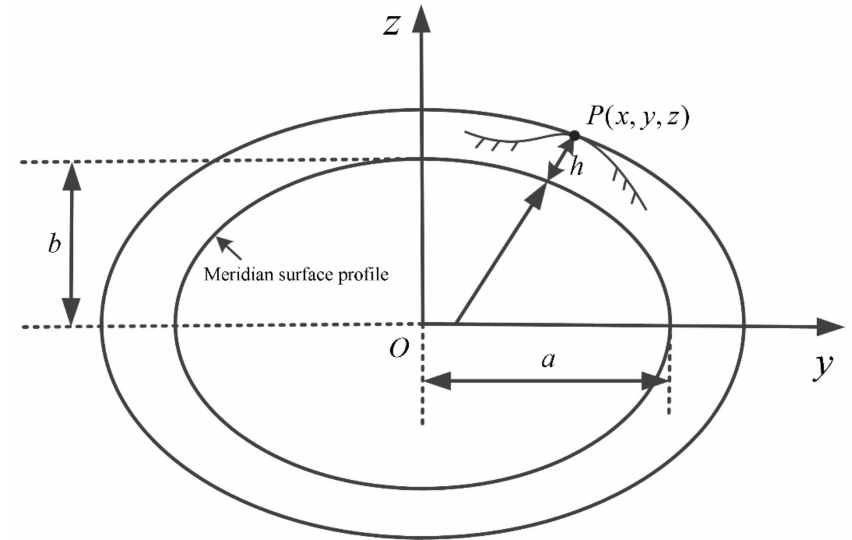
Figure 2. Approximate reference ellipsoidal meridian profile where the ground user is